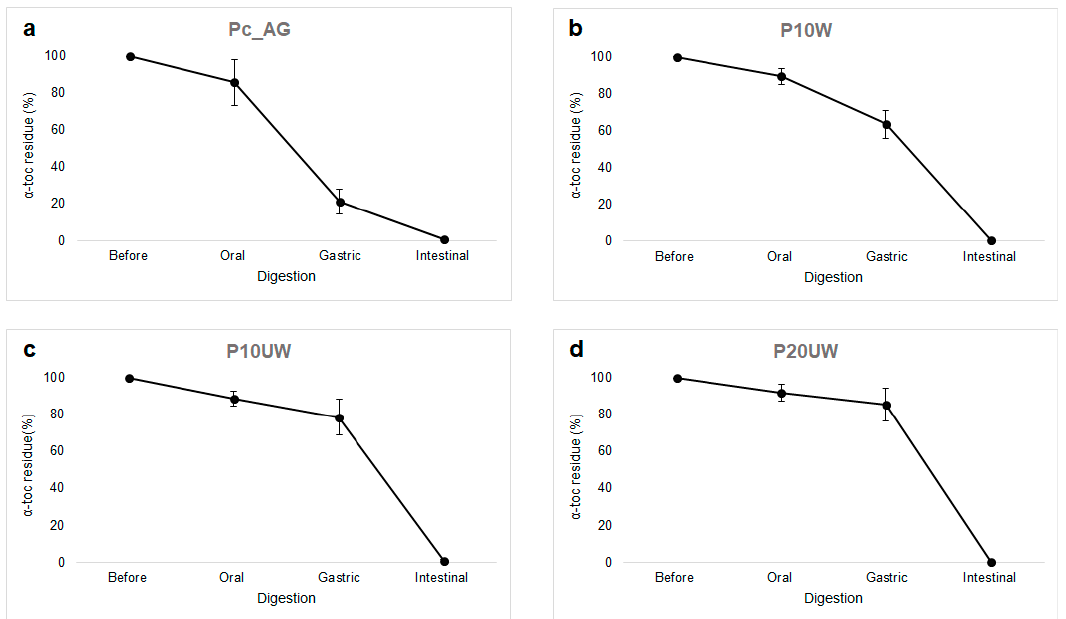
Figure 2. Effect of in vitro digestion on the vitamin E degradation in SO reconstituted emulsions stabilized with AG ( a ), β -glucan-rich extracts washed ( b ), and unwashed ( c , d ). Sample codes are explained in Section 2.2.1. Results presented are representative data for three separate experiments.